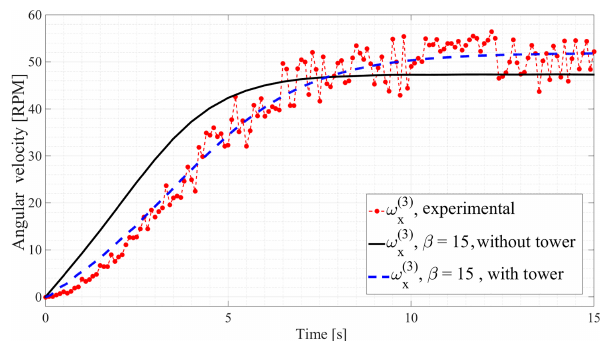
Figure 9. Comparison of rotor velocity at β = 15 ◦ .